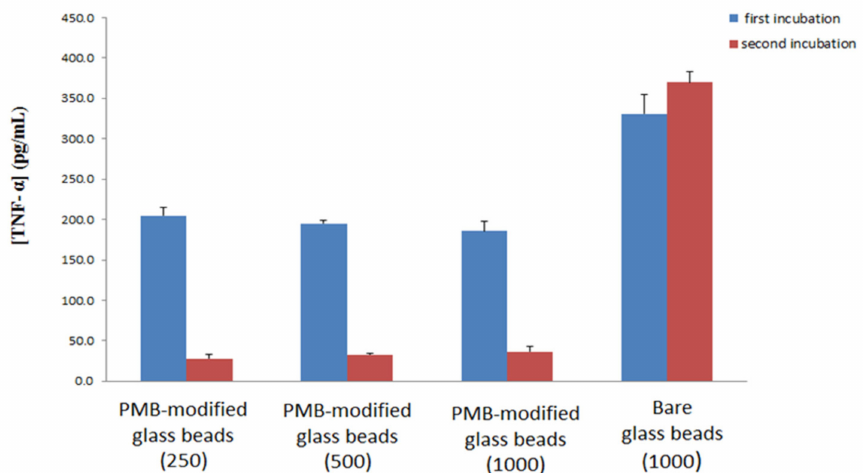
Figure 7. Production of TNF- α cytokine upon two incubations: First incubation (blue) of LPS-spiked donor blood with PMB-modified glass beads or bare glass beads and subsequent incubation with naïve blood (red) with standard deviation. Numbers in brackets indicate number of glass beads used for the first